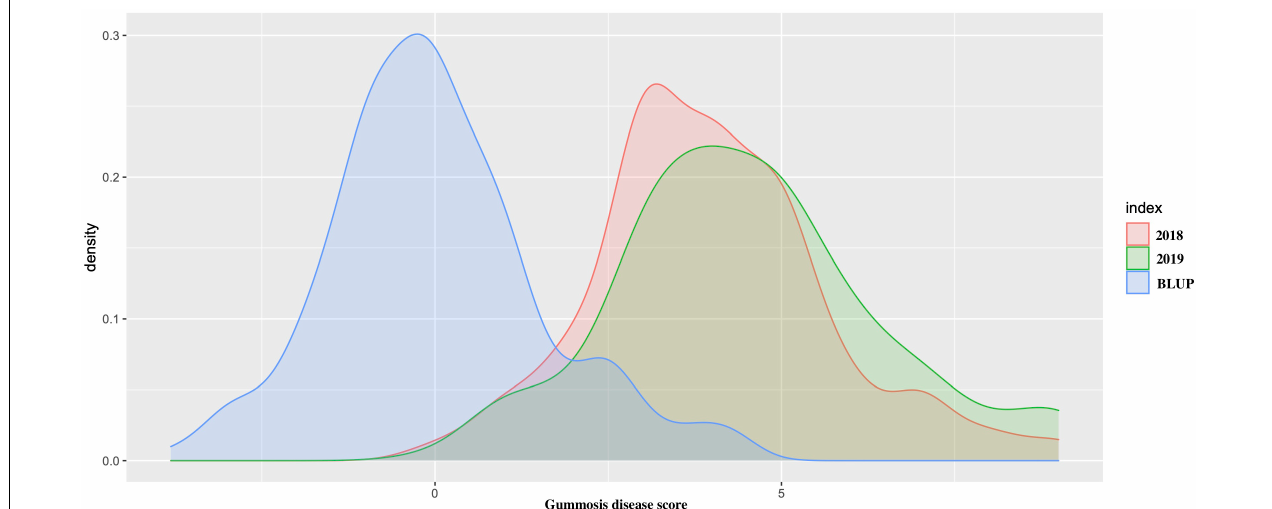
FIGURE 1 | The density distribution of peach gummosis in 195 peach accessions. Disease scale of 0–9 was used, where 0 and 1 represent highly resistant and 9, highly susceptible accessions. The red density distribution is the phenotypic data obtained from 2018; green is the density distribution of the phenotypic data obtained from 2019, and blue represents the density distribution of the best linear unbiased predictions (BLUPs) expressed as estimated breeding values.